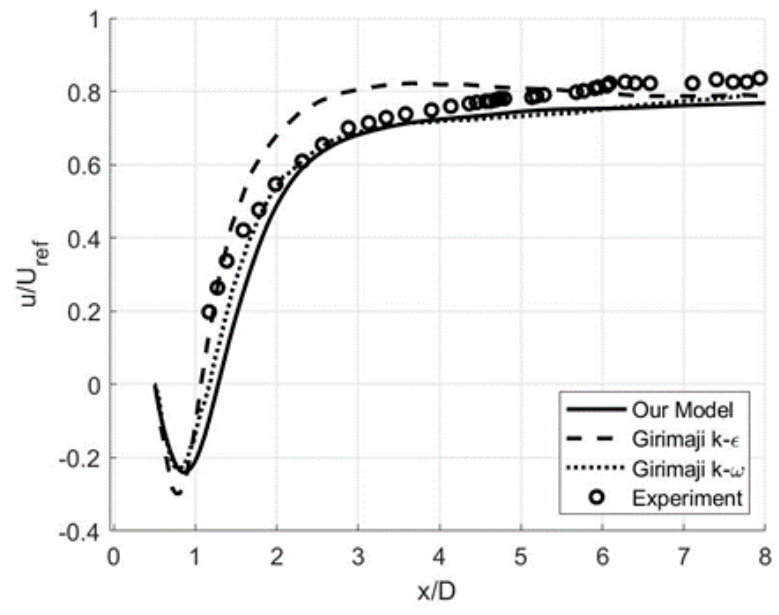
Figure 15. The mean centerline streamwise velocity profile ( f ε = 1.0, f k = 0.5 ) .